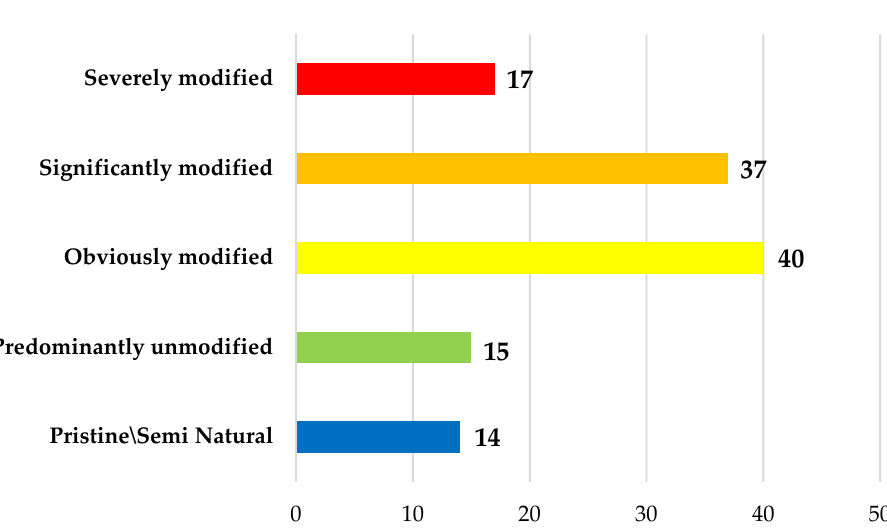
Figure 5. Number of sites per class according to hydromorphological modification (HMS). According to the results of the Kruskal–Wallis test, QBR and RQI were statistically different ( p < 0.005 and p = 0.040, respectively) among the Water Districts. Specifically, post hoc comparisons showed several significant differences ( p ≤ 0.002) for QBR such as between water districts GR04 (Western Central Greece) and GR01, 08, 10, and 11. Similarly for RQI, post hoc comparisons showed significant differences ( p ≤ 0.004) between GR 01 (Western Peloponnese) as well as most of the other Water Districts and GR04, 03, 05, and 07. However, QBR was also statistically different among River types ( p = 0.004), while RQI was not. Indicatively, QBR medians were statistically different between R-M2 and R-M4 river types. This could be explained by the fact that River Types are defined by